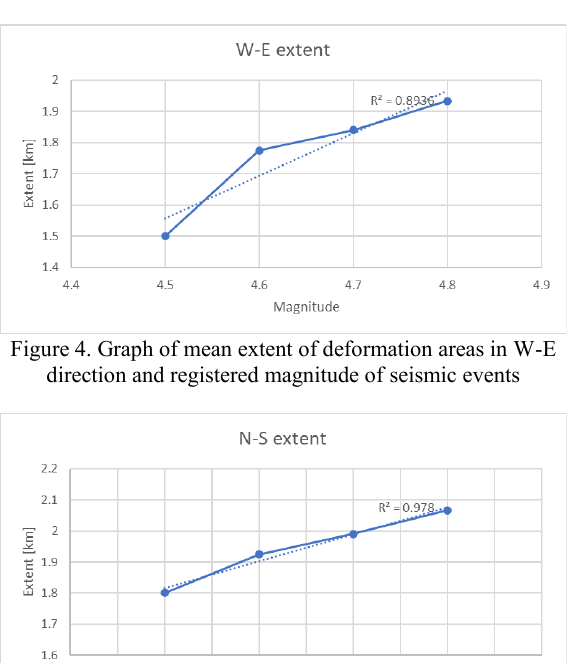
Figure 3. Graph of mean maximum vertical displacement and registered magnitude of seismic events